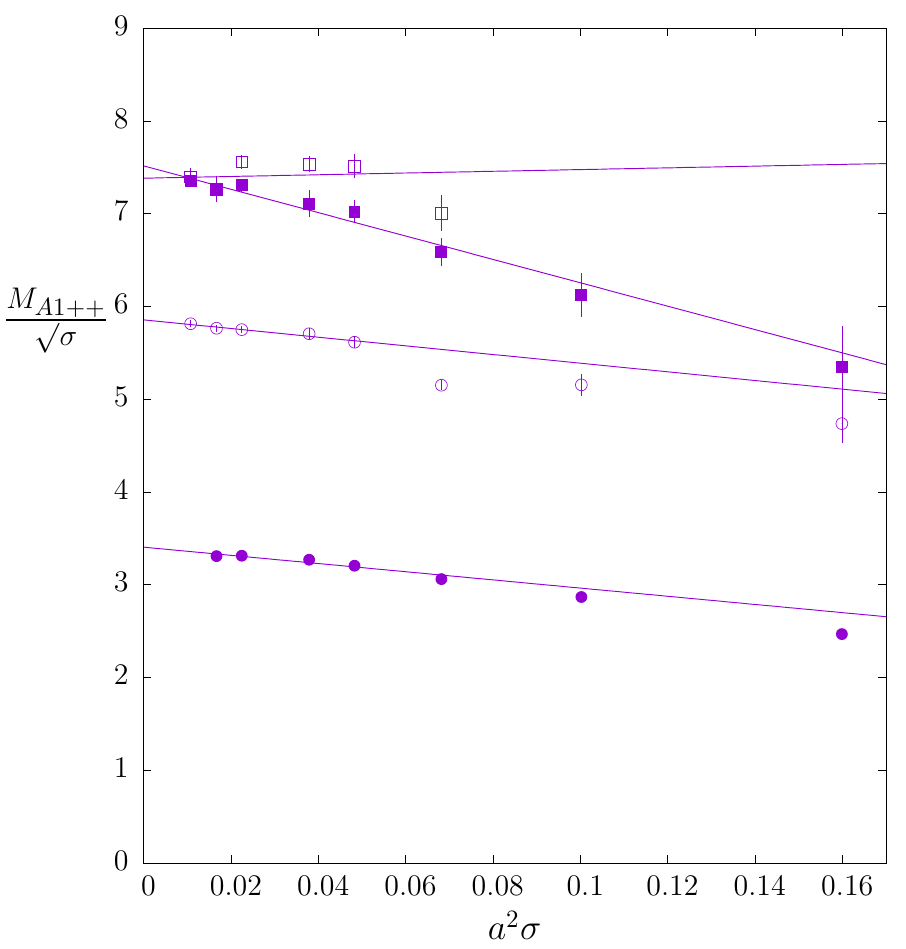
Figure 12 . Continuum extrapolations of the lightest two J PC = 0 ++ glueballs, • and ◦ , as well as the next two heavier A 1 ++